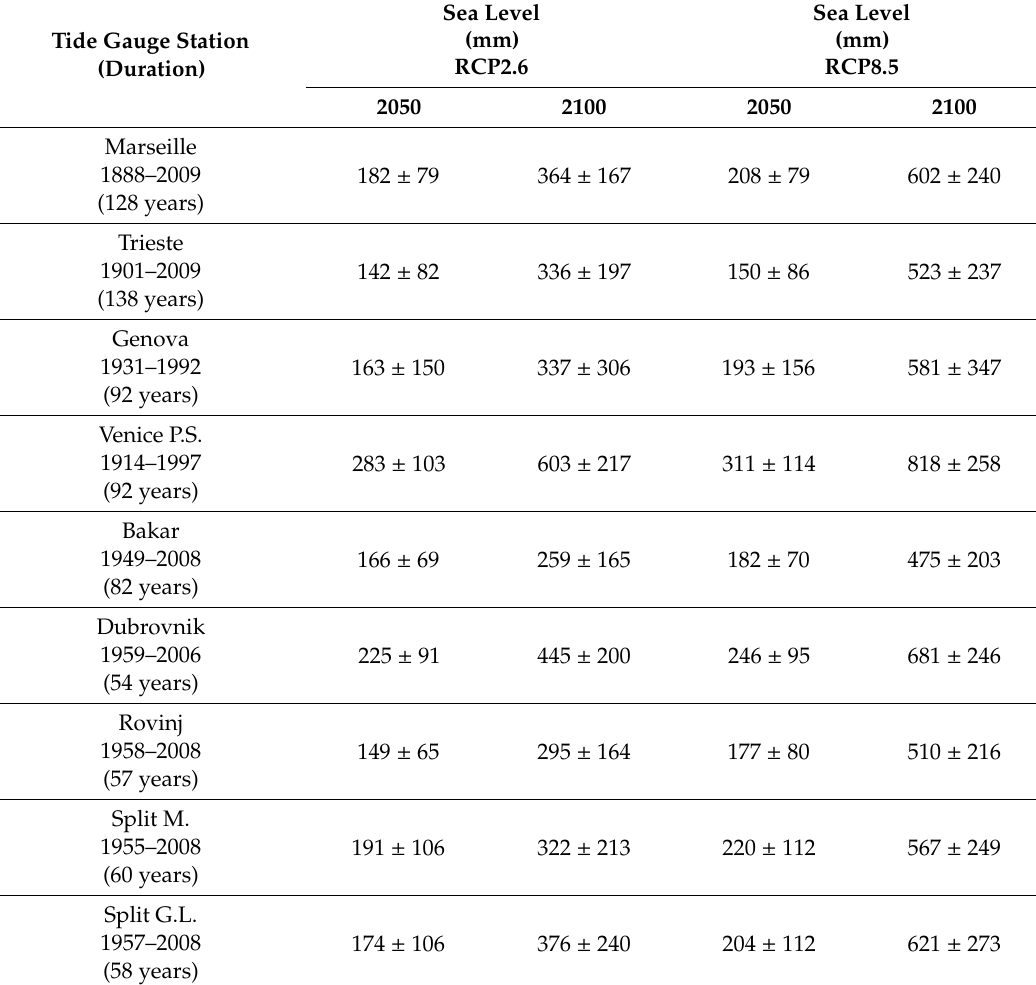
Table 4. Sea levels for 2050 and 2100, with respect to 2005, at the tide gauge for the two scenarios RCP2.6 and RCP8.5 including both the VLM and sea level natural variability (SLNV) contribution. Uncertainties define the 90% confidence limits. Time span used for the modeling and duration of raw records (in parenthesis) are also indicated. Since cGPS data are not reliable, the contribution of VLM is not included for Bakar and